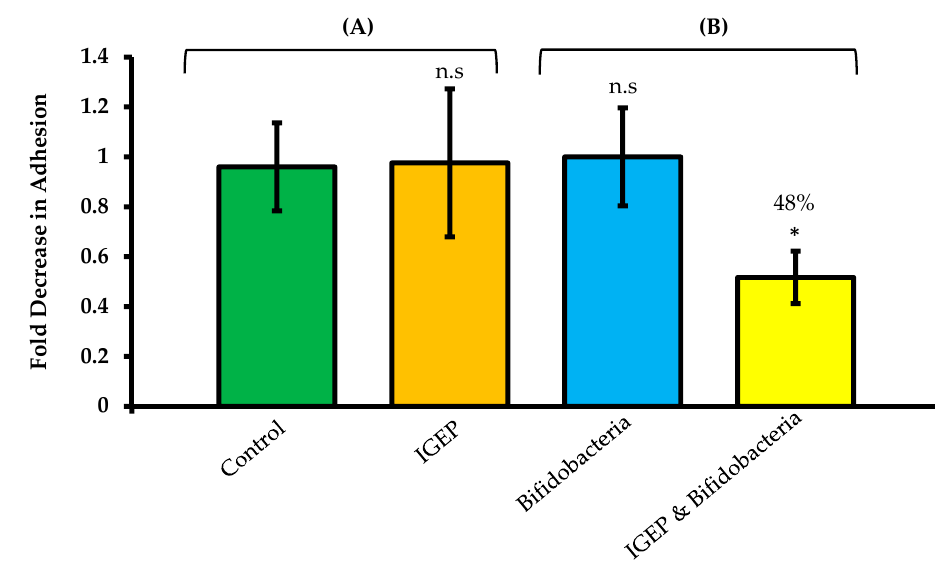
Figure 3. Anti-infective assays ( A ) demonstrating Campylobacter jejuni 81–176 adhesion in the absence (green) and presence (orange) of IGEP. ( B ) Competitive exclusion assays demonstrating C. jejuni 81–176 adhesion to HT-29 cells following pre-treatment of the HT-29 cells with B. infantis 15697 (blue) and B. infantis 15697 pre-treated with IGEP (yellow). Results are represented as the average of one biological replicate experiment performed in technical triplicate ( A ), and the average of three biological replicate experiments performed in technical triplicate ( B ), and are represented as a percentage of adherent cells = (CFU / mL of recovered adherent bacteria ÷ CFU / mL of inoculum) × 100, and graphed as fold-change relative to percent adhesion of control, with error bars representing ± one standard deviation. The Student t -tests were used to test for significance in comparison to the control ( A ), or in comparison to un-treated bifidobacteria ( B ). *, p -value < 0.05; n.s., not significant.